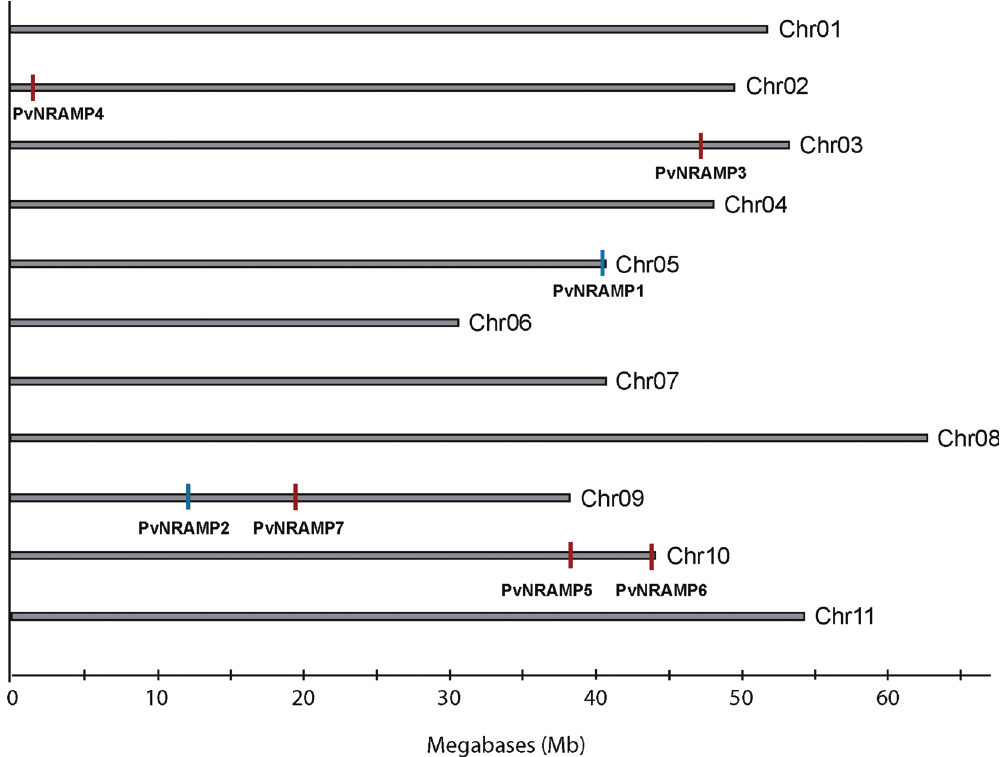
Figure 2 - Distribution of genes in P. vulgaris chromosome. Chromosome size is indicated by its relative length. The scale on the bottom is shown in megabases (Mb). The blue bars mark the gene location at the forward direction, while the red bars mark the gene at the reverse position. The figure was generated by Geneious software and edited using the package Adobe Illustrator.